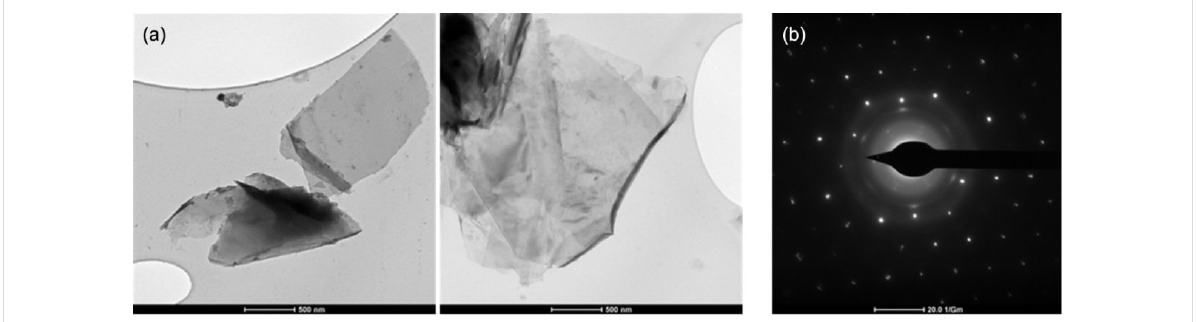
Figure 3: (a) TEM images of GMSE1 graphene sheets; (b) Diffraction pattern of GMSE1.